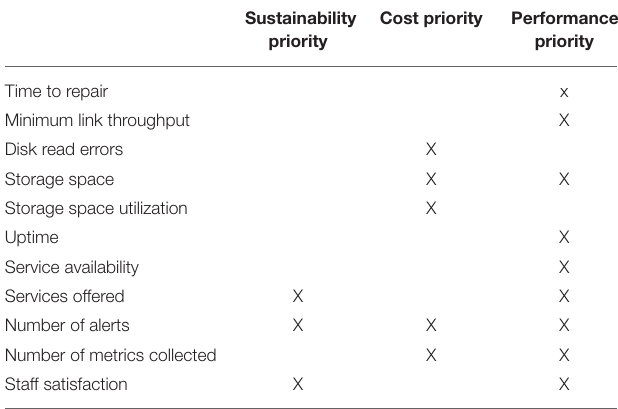
TABLE 3 | SLA metrics for sustainability, cost and performance service